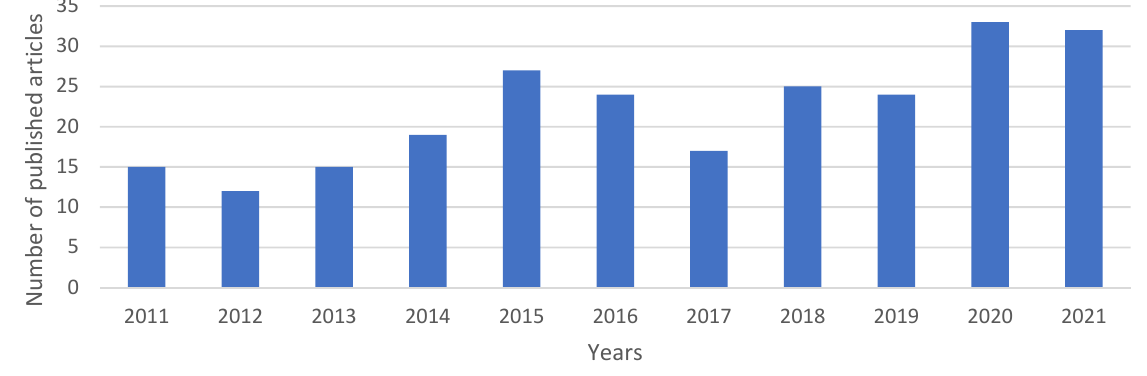
Figure 2. Articles found in the databases searched per year (10 years).